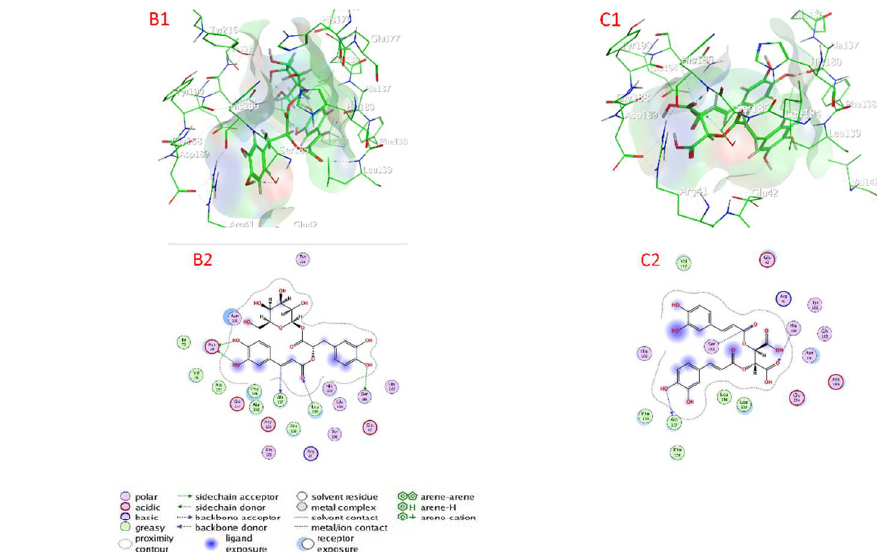
Figure 7. Docking view of ( A1 , A2 ) quercetin-3-O-rutinoside, ( B1 , B2 ) rosmarinic acid glucoside, and ( C1 , C2 ) chicoric acid in the binding sites of metalloprotease (PDB:1KAP); ( A1 , B1 , C1 ) 3D complex structures (stereoview) and ( A2 , B2 , C2 ) 2D interaction diagram structures.